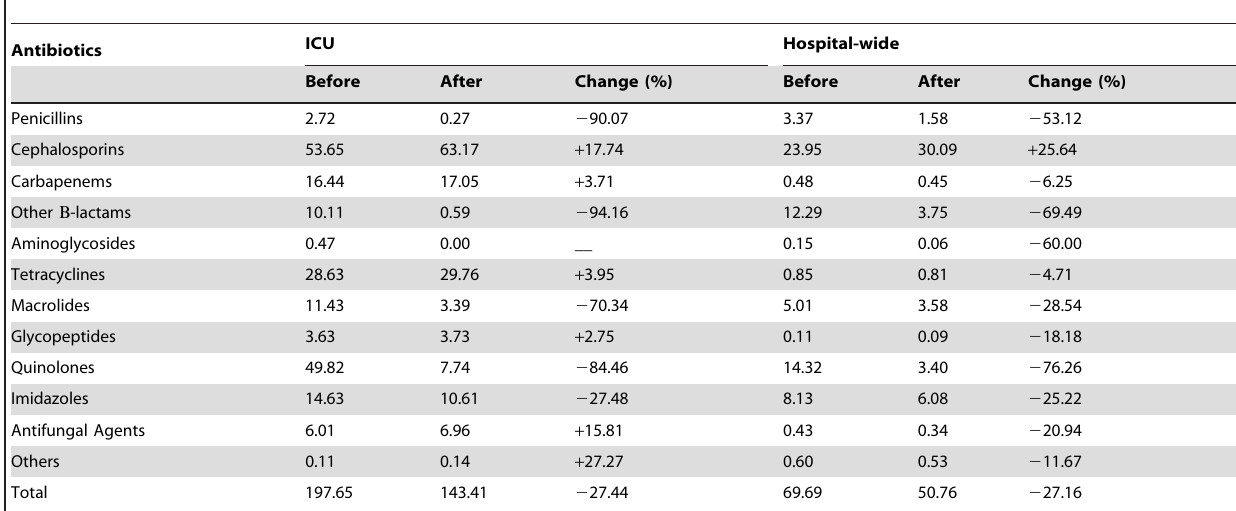
Table 2. Changes of antimicrobial consumption (DDDs/100 patient/days) after the antimicrobial stewardship.